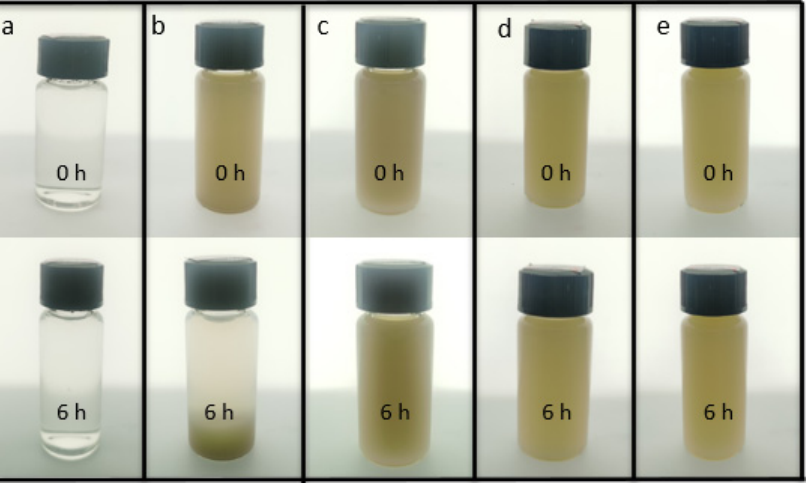
Figure 1. The initial states and states after 6 h of ( a ) CNF; ( b ) HNTs; ( c ) CNF / HNTs; ( d ) HNTs- KH560-CNF; ( e ) HNTs- KH570-CNF nanoparticle solution CNF; ( e ) HNTs-KH570-CNF nanoparticle